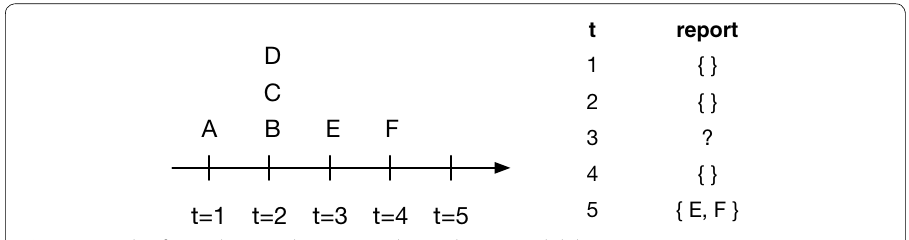
Fig. 3 Example of time-driven T ick: count window with size 2 and slide